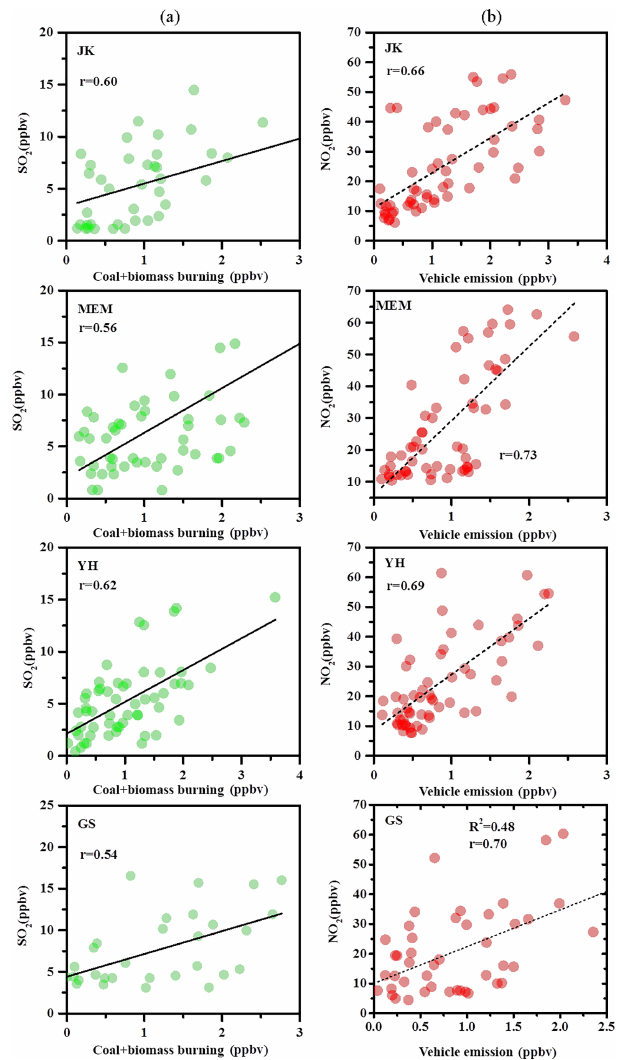
Figure 16. Correlation analysis relating source-apportioned VOC contributions of coal + biomass burning (a) and vehicle emis- sions (b) with co-located measurements of SO 2 and NO 2 for each site